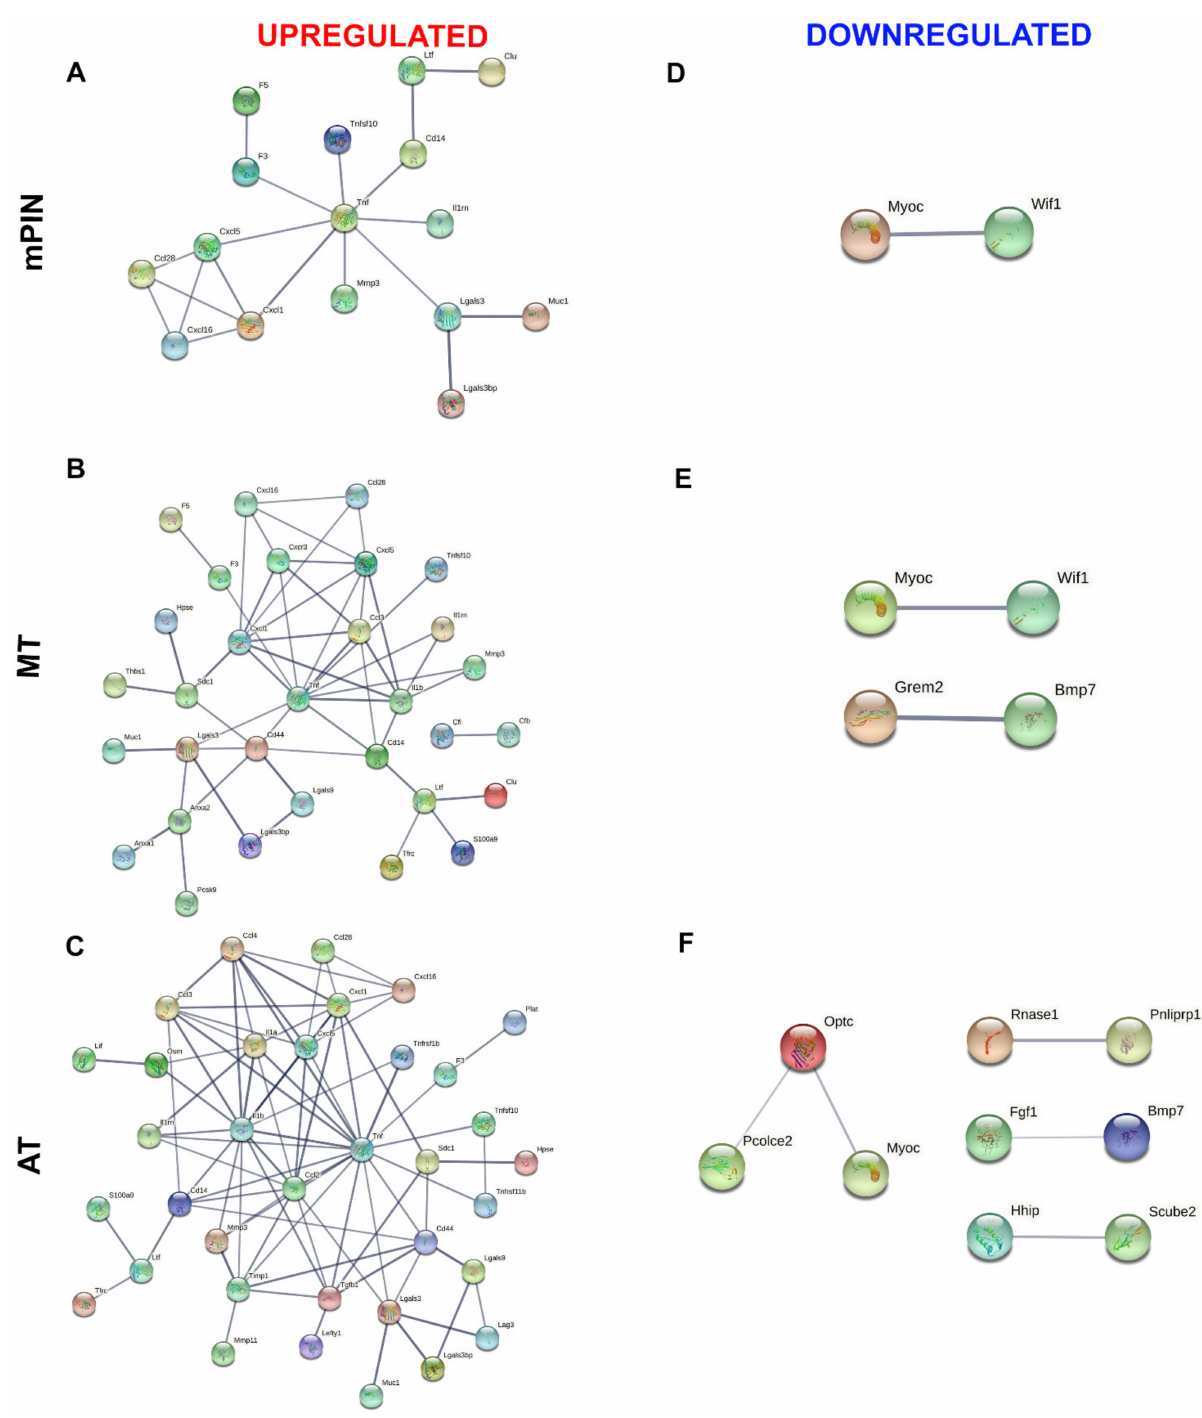
Figure 5. The PPI network involves common genes analysis of a cluster of secreted proteins of PCa in Pten knockout mice. PPI of commonly upregulated genes in mPIN ( A ), MT ( B ), and AT ( C ), and downregulated genes in mPIN ( D ), MT ( E ), and AT ( F ). Analysis using STRING [39] illustrates potential interactions. Proteins in the interaction network are represented as nodes connected by lines whose thickness reflects a confidence index higher than 0.7. mPIN = mouse Prostatic Intraepithelial Neoplasia; MT = Middle-stage tumor; AT = Advanced-stage